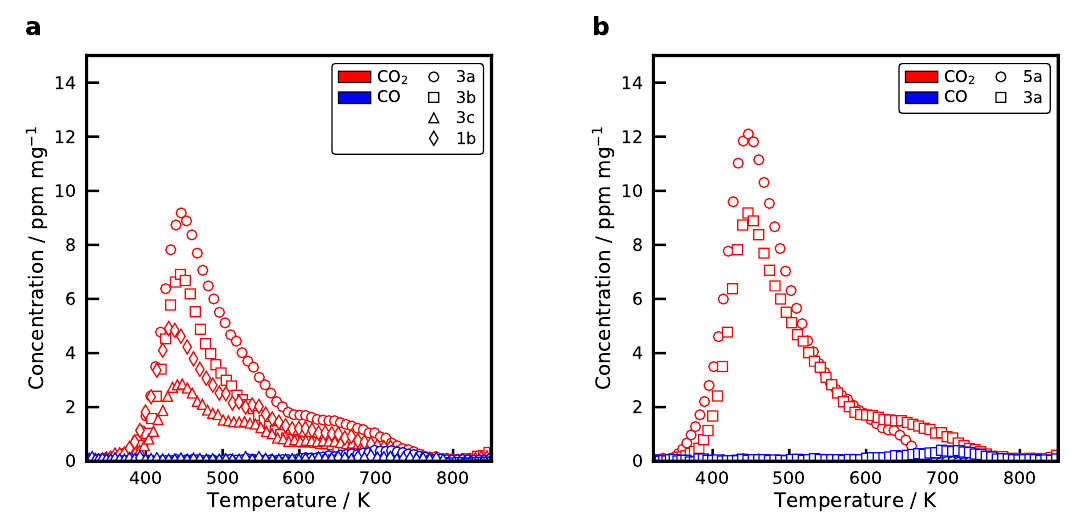
Figure 8. Temperature-programmed desorption of selected ( a ) Ni/SiO 2 catalysts and ( b ) Ni/ γ -Al 2 O 3 catalysts after CO 2 adsorption at flow conditions at 383K for 1h. Conditions: m cat = 30mg, β = 20Kmin − 1 , ˙ V Ar = 30mL N min − 1